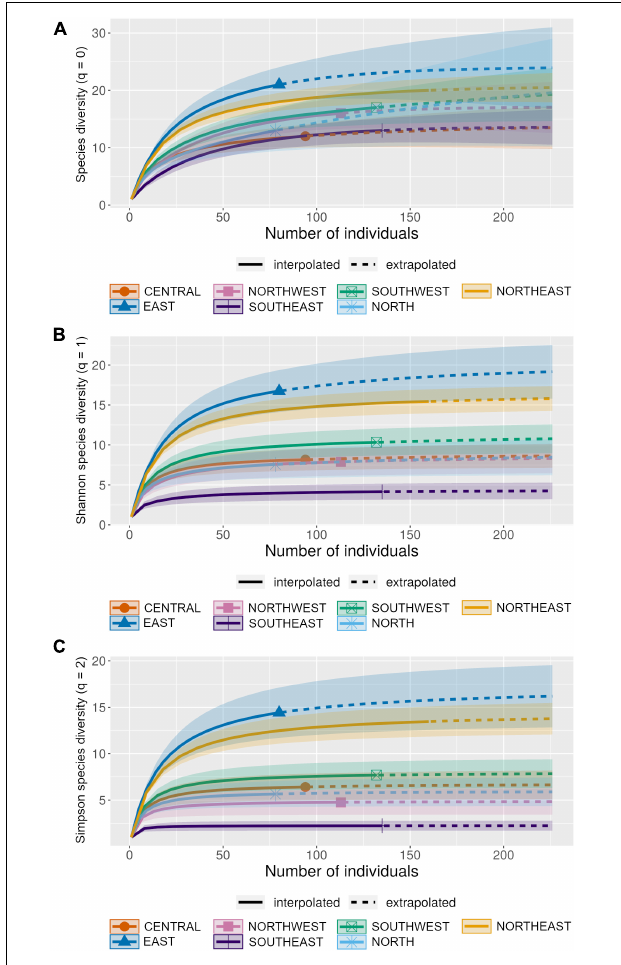
FIGURE 6 | Rarefaction and extrapolation curves based on abundance data for each locality surveyed in the Cerrado. The sample-based curves were generated on the online iNEXT platform (Hsieh et al., 2016). (A) Observed species richness ( q = 0), (B) observed Shannon index ( q = 1), and (C) observed Simpson index ( q = 2). CENTRAL = Área Alfa Cerrado Reserve, EAST = Grande Sertão Veredas National Park, SOUTHEAST = Santa Bárbara Ecological Station, NORTHWEST = Serra das Araras Ecological Station, SOUTHWEST = Serra da Bodoquena National Park, NORTH = Serra Geral do Tocantins Ecological Station, NORTHEAST = Uruçuí-Una Ecological